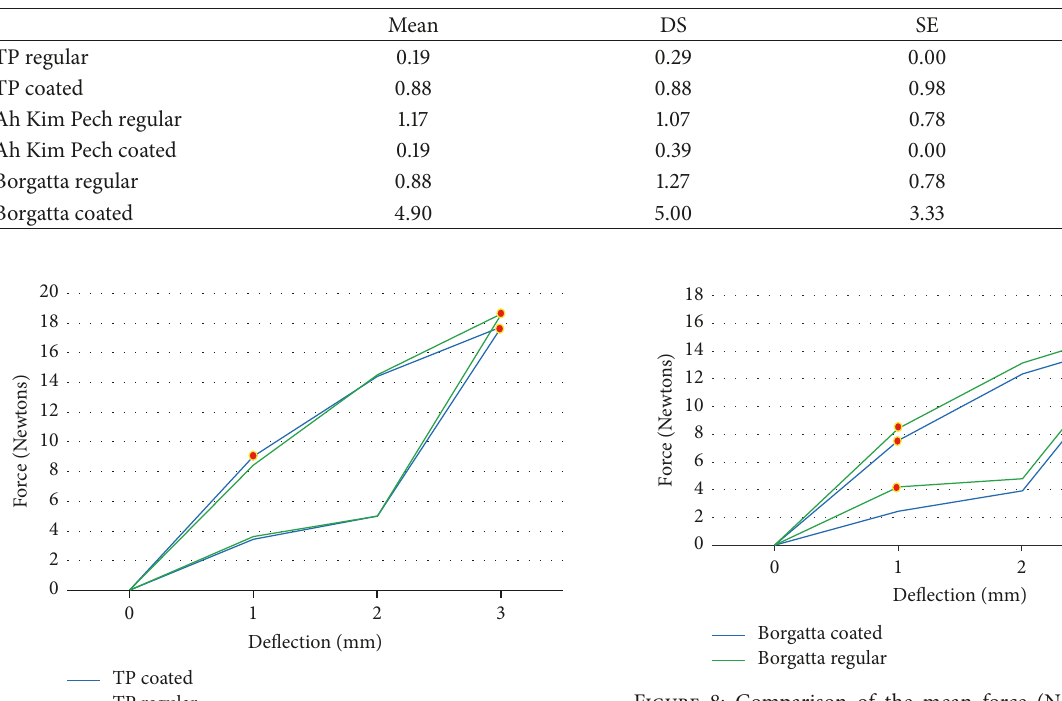
Figure 8: Comparison of the mean force (N) load and unload deflection between the coated and regular rectangular Borgatta 0.016 󸀠󸀠 × 0.022 󸀠󸀠 Ni-Ti wires. There was a statistically significant decrease in the coated Ni-Ti wires at 1mm ( 𝑝 < 0.01 ) and 3 mm ( 𝑝 < 0.01 ) load deflection compared with the regular Ni-Ti wire. There was a statistically significant increase in the unload deflection in the regular Ni-Ti wire at 1mm compared to that of the coated wire ( 𝑝 < 0.01 ).